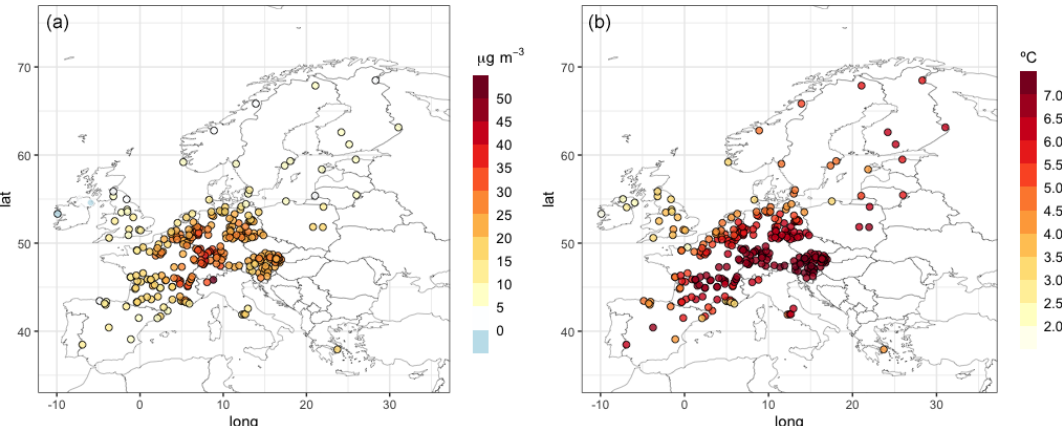
Figure 1. Anomalies of MDAO3 (a) and T max (b) for blocking days (i.e. BI = 1). Anomalies of MDAO3 were calculated with respect to the MDAO3 concentrations over the whole period 1999–2015 during the ozone season, April–September. Similarly, anomalies of temperature were obtained with respect to the temperature over the whole period of study (as for MDAO3). Black contour indicates statistically significant anomalies at the 95% confidence level of a two-sided t